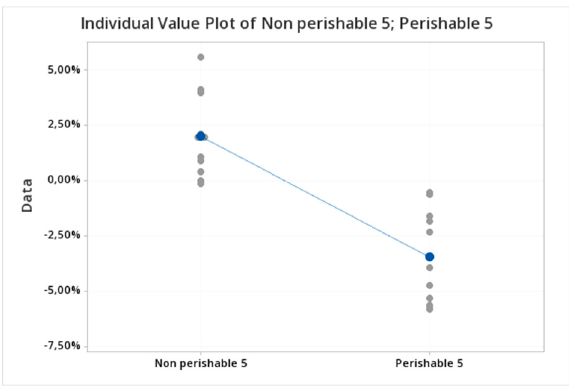
Figure 11. Individual plot CAARs event window E ( − 5,+5) .